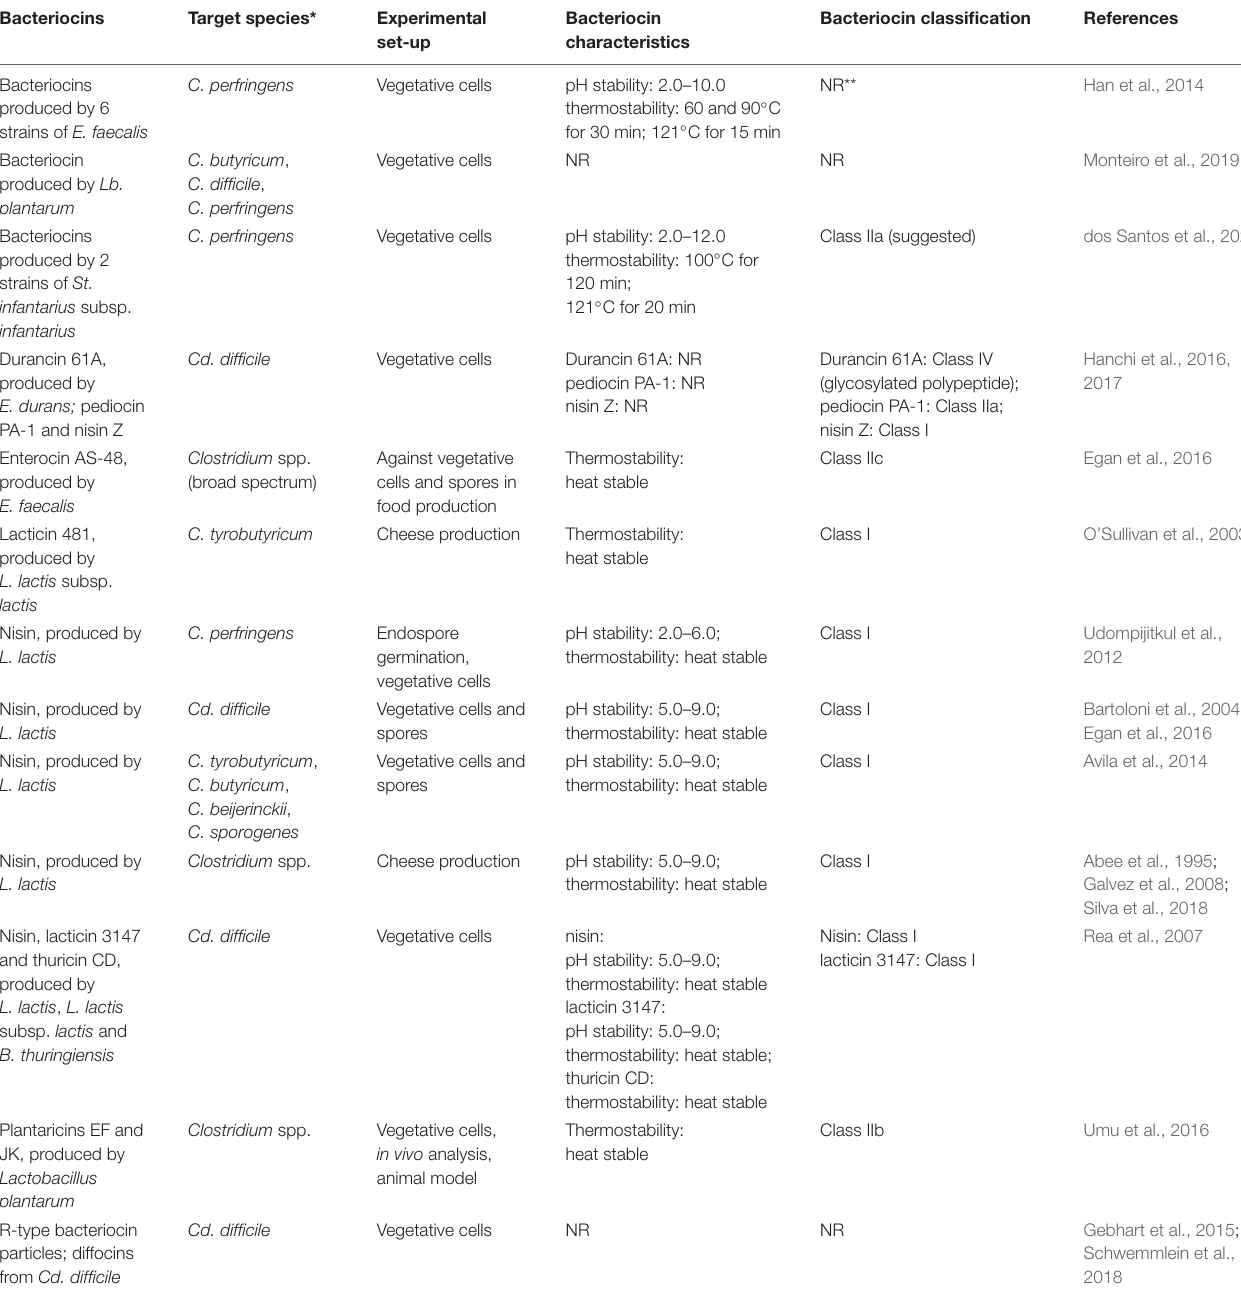
TABLE 1 | Bacteriocins and their producer strains showing activity against Clostridium ( C .) and Clostridiodes ( Cd .) species with special focus on those associated with